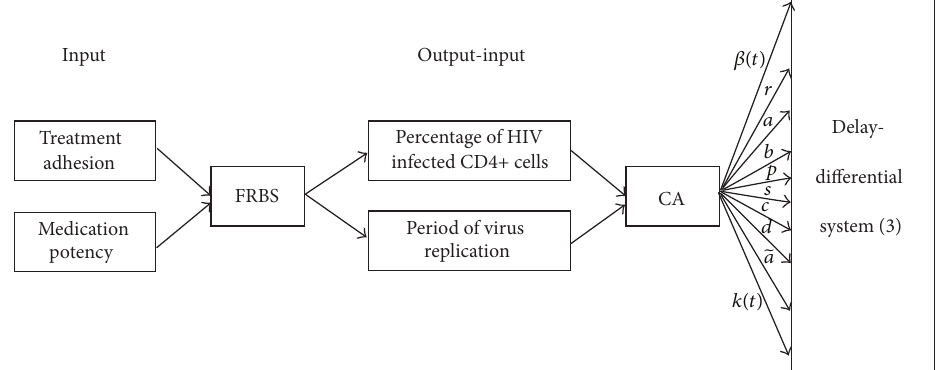
Figure 1: Schematic representation of the methodology utilized to obtain the parameters of system (3). −̃𝑎𝜏 from 𝑡−𝜏 to time 𝑡 is only 𝑒 . More generally, the probability of survival is given by a nonincreasing function 𝑓(𝜏) with 0 ≤ 𝑓(𝜏) ≤ 1. Thus, the model can be written